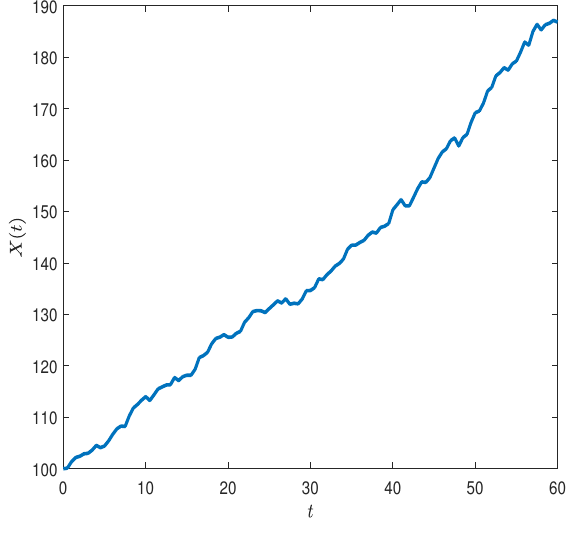
Figure 1. Wealth X ( t ) as a function of t .